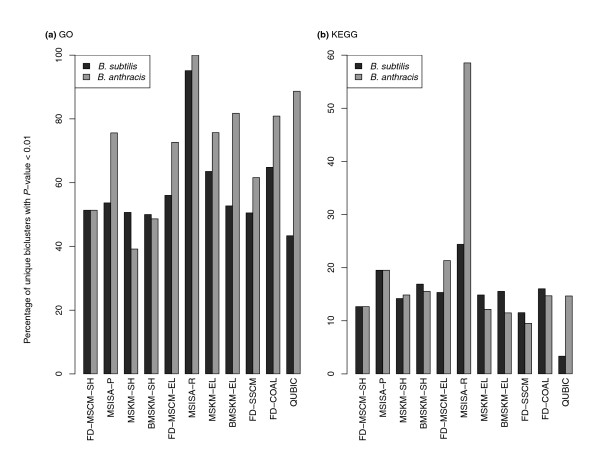
Comparison of the fraction of biclusters with significant GO and KEGG annotation enrichments for the single and multi-species methods for the B. subtilis-B. anthracis pairing. (a) GO terms. For all multi-species methods there is a consistent increase from the shared to elaboration step, with the percentage of elaborated biclusters with significant GO term enrichments consistently greater than those from the single species optimization. (b) KEGG pathways. For both of the multi-species biclustering methods (MSCM and MSISA), there is a consistent increase in percentage from the shared to elaborated optimizations, similar to the GO term enrichments, with a similarly large increase for the refined MSISA biclusters for B. anthracis. The two k-means clustering variants showed either negligible increase or even a decrease between the shared and elaboration steps.